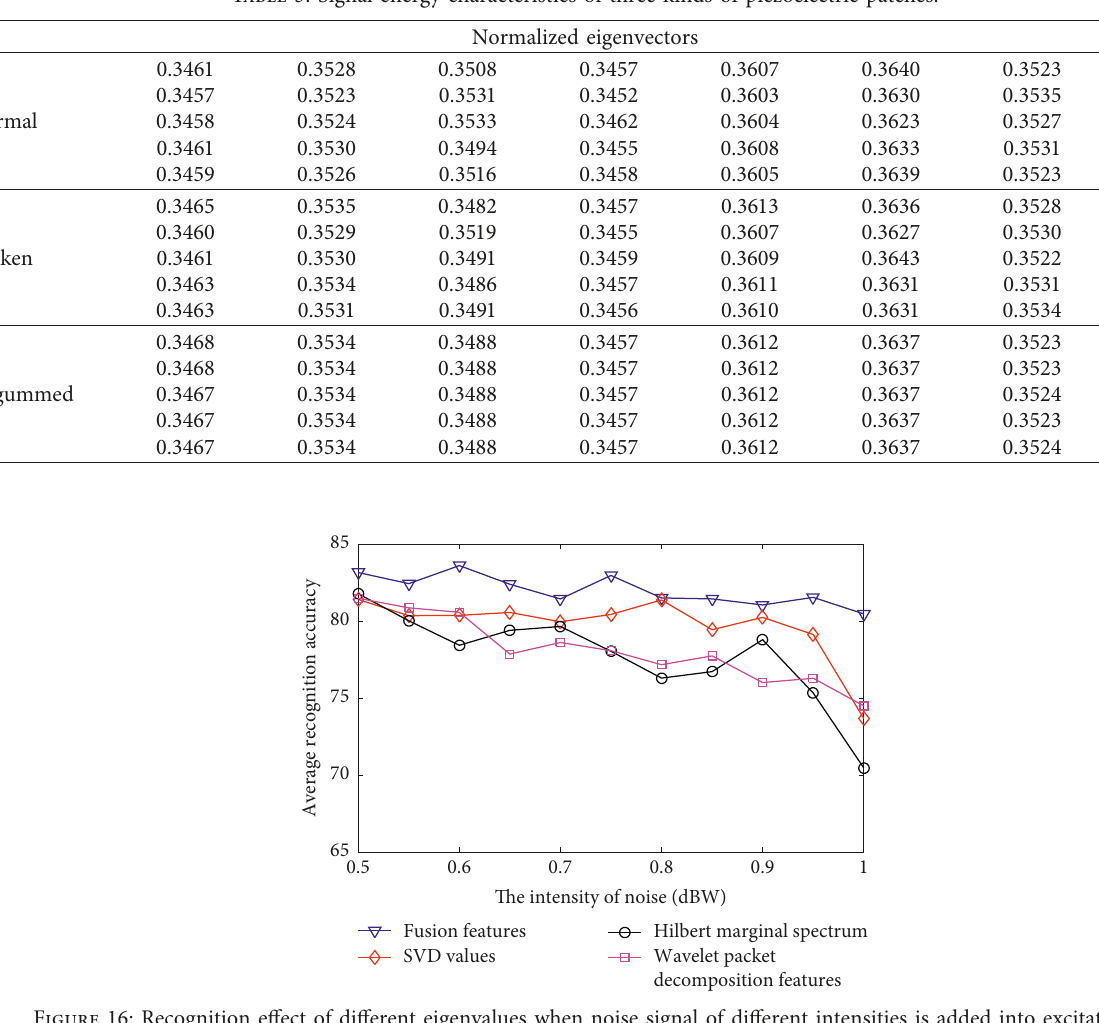
Table 5: Signal energy characteristics of three kinds of piezoelectric patches.